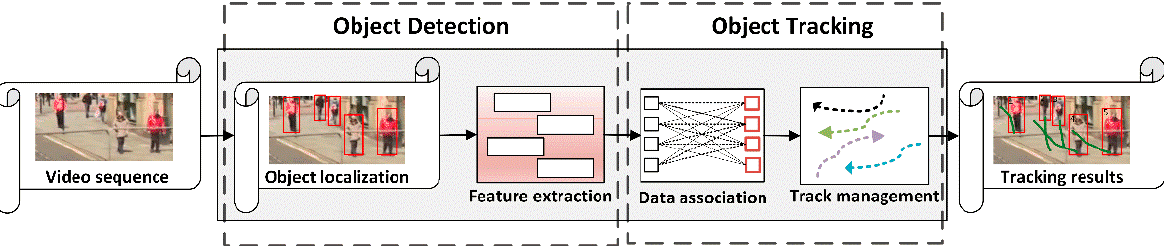
Figure 4. The main procedures of TBD framework, which consists of four core components. The four core components contain object localization, feature extraction, data association, and track management. (Source: This image is from the MOT16 dataset [25] ).